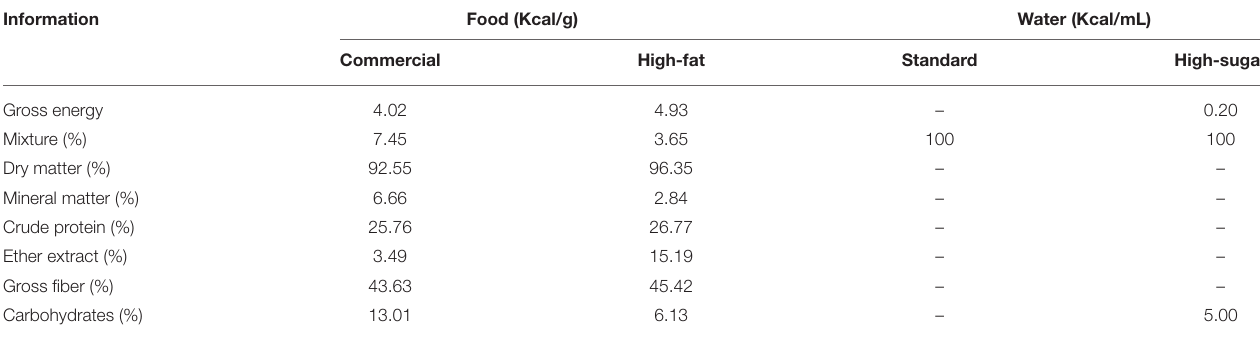
TABLE 1 | Nutritional values of diet offered to non-diabetic and diabetic